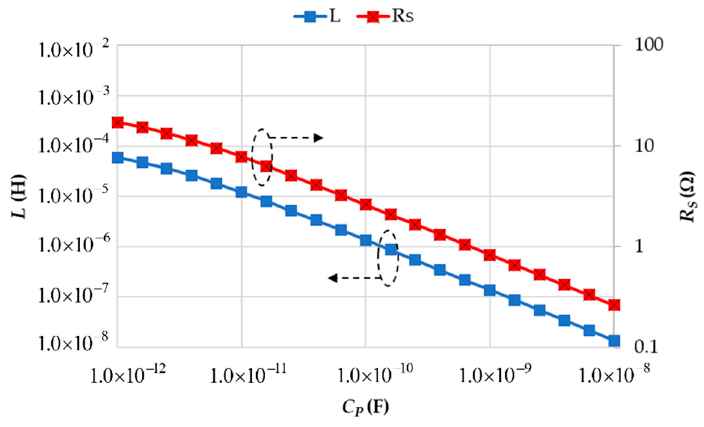
Figure 13. Series resistance of the resonant inductor with the change of the parasitic capacitance.